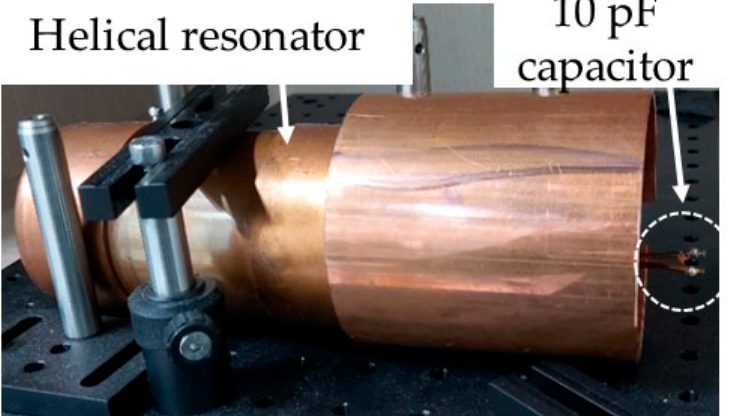
Figure 1. An experimental structure amplifying the RF signal applied to ion traps using a helical